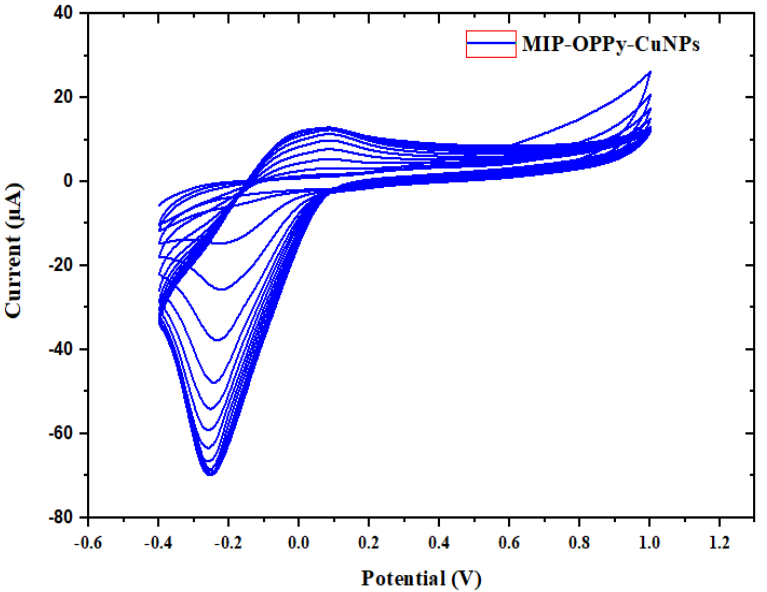
Figure 4. Cyclic voltammograms of the electrodeposition of CuNPs. Experimental conditions: 0.1 M Na 2 SO 4 , 10 − 3 M CuSO 4.